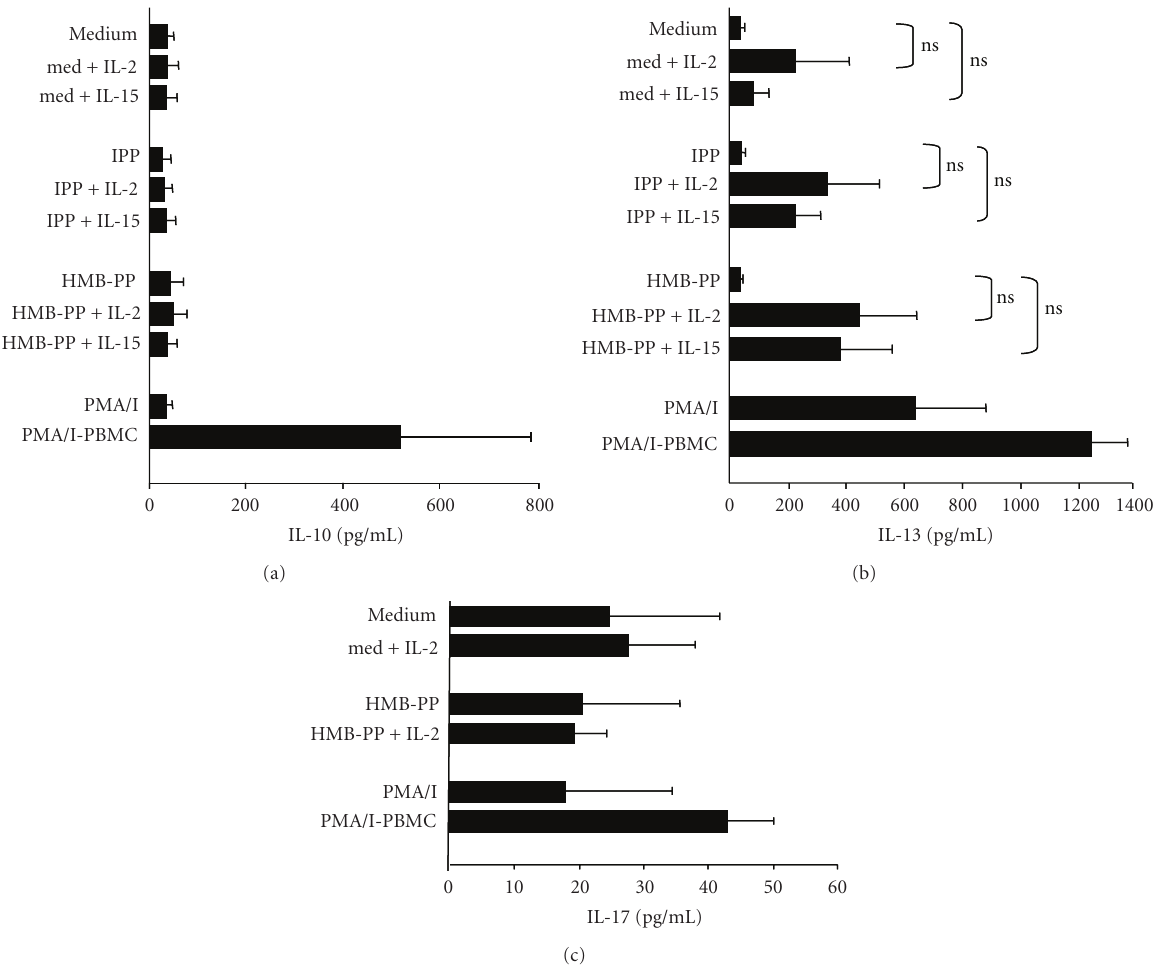
Figure 4: Phosphoantigen stimulation of γδ T cells causes no detectable increase in IL-10, IL-13, or IL-17 production. Freshly isolated PBMCs were enriched for γδ T cells using magnetic beads, and 200,000 cells were stimulated with 10 μ M IPP, 10nM HMB-PP, 50 U/mL IL-2, and/or 10 ng/mL IL-15 as indicated. The levels of IL-10 (a), IL-13 (b), and IL-17 (c) in cell supernatants were measured by ELISA after 72 hours. Bar charts show mean cytokine levels for all treatments for 8 donors. ns: not significant comparing absence and presence of IL-2 and IL-15. PMA/I-PBMC, cytokine levels released by PMA and ionomycin-stimulated